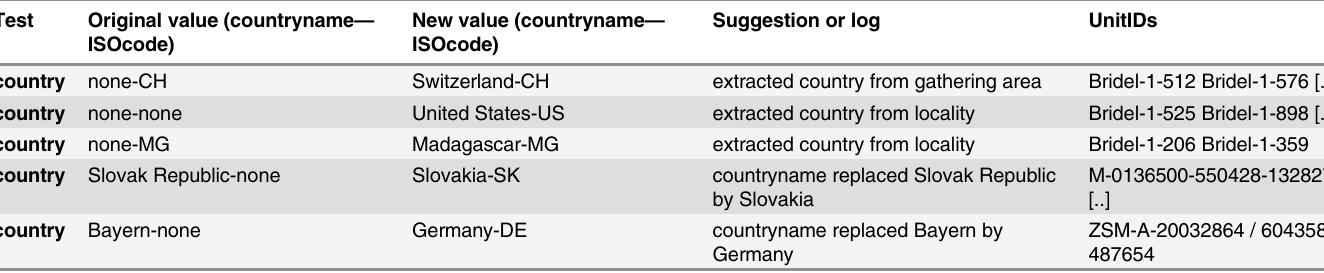
Table 3. Export subset of the quality